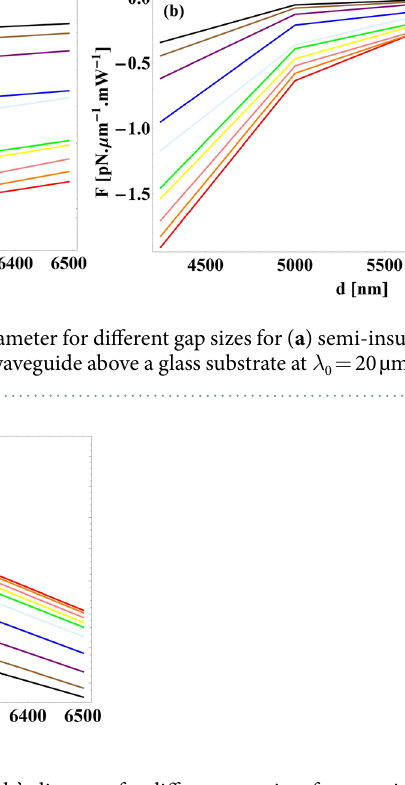
Figure 5. Propagation length versus waveguide’s diameter for different gap sizes for a semi-insulating InP waveguide above a glass substrate at λ 0 = 20 µ m. Legend is the same as Fig. 4.